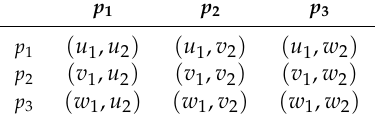
for all ( θ 1 , θ 2 ) ∈ Θ e 1 , θ 2 )